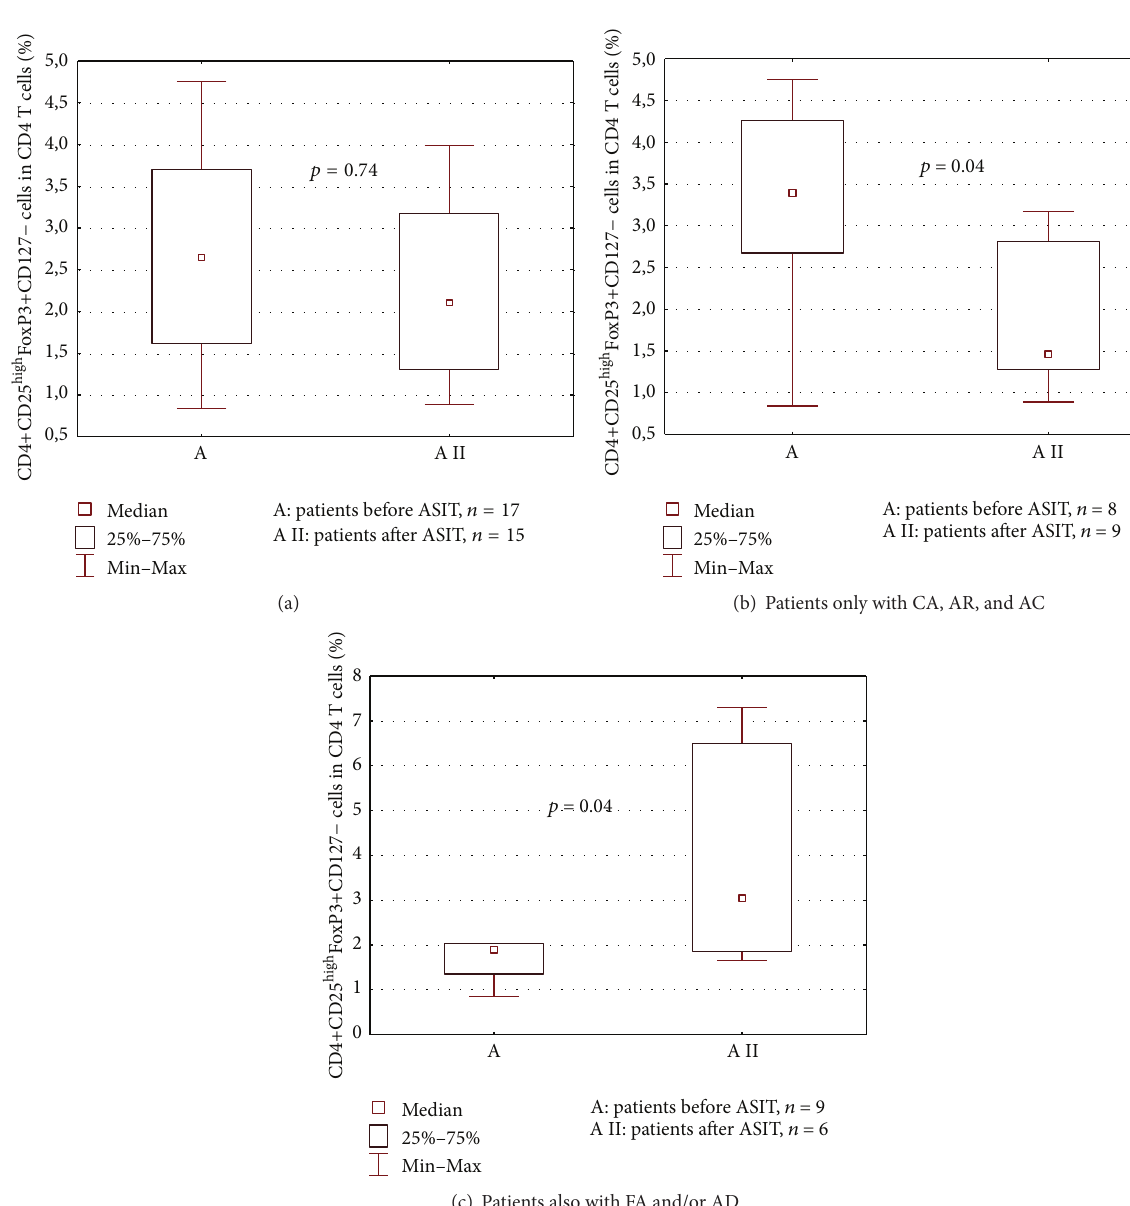
Figure 2: The percentage of CD4+CD 25 high FoxP3+CD127 − Tregs in CD4 T cell population in peripheral blood of patients with allergy before ASIT (A) and after ASIT (A II). (a) All patients, (b) first group of patients, only CA, AR, and AC, and (c) second group of patients, with FA and/or